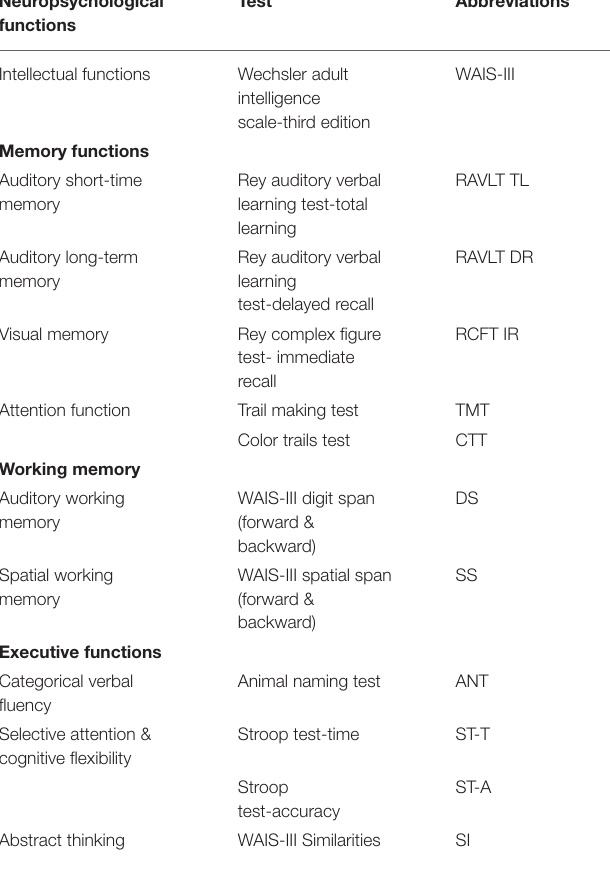
TABLE 1 | Neuropsychological functions and